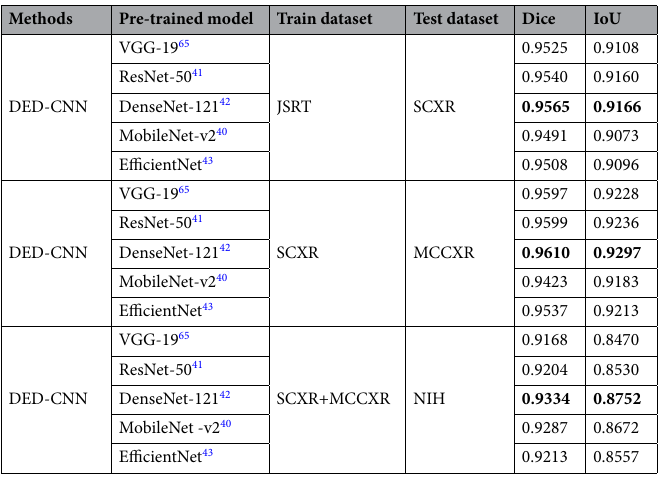
Table 7. Cross-dataset qualitative comparisons of the component of the proposed approach. The values in bold represent the best performances.